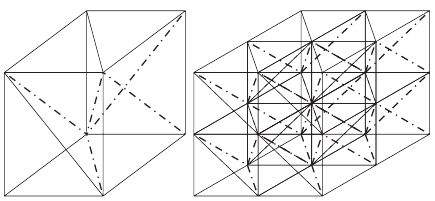
Figure 8: Simplices constructed for three dimensional